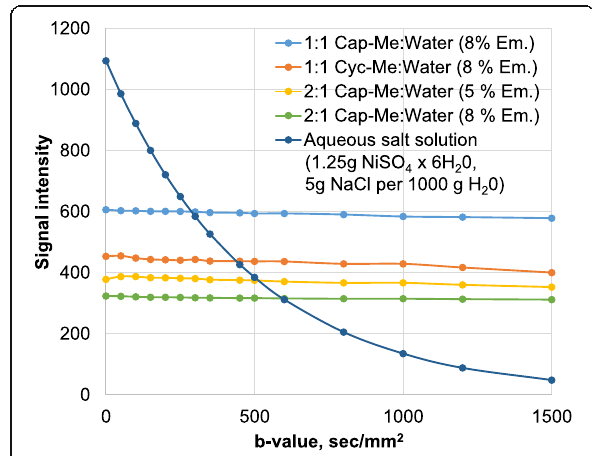
Fig. 6 Dependency diagram of DWI signal intensity to b value for emulsions with different fat and water phase